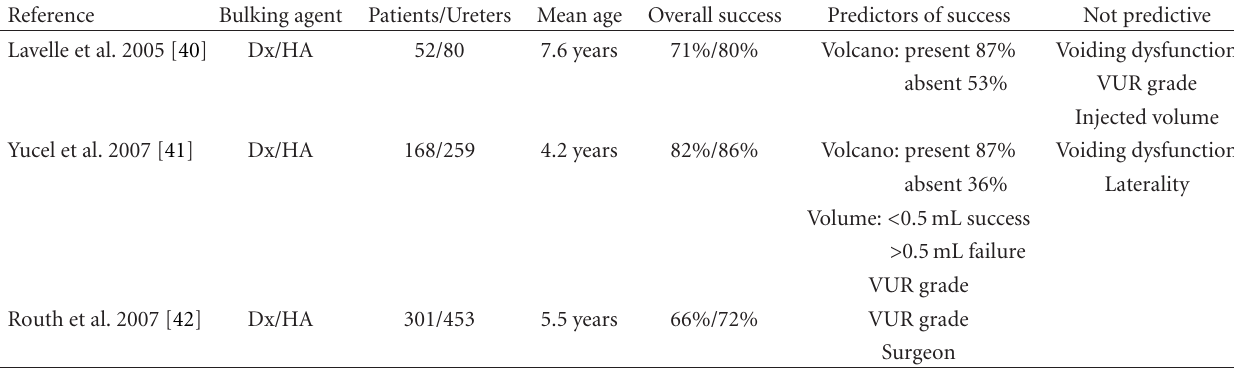
Table 3: Variables a ff ecting the outcome of endoscopic treatment of VUR with Deflux. Overall success for